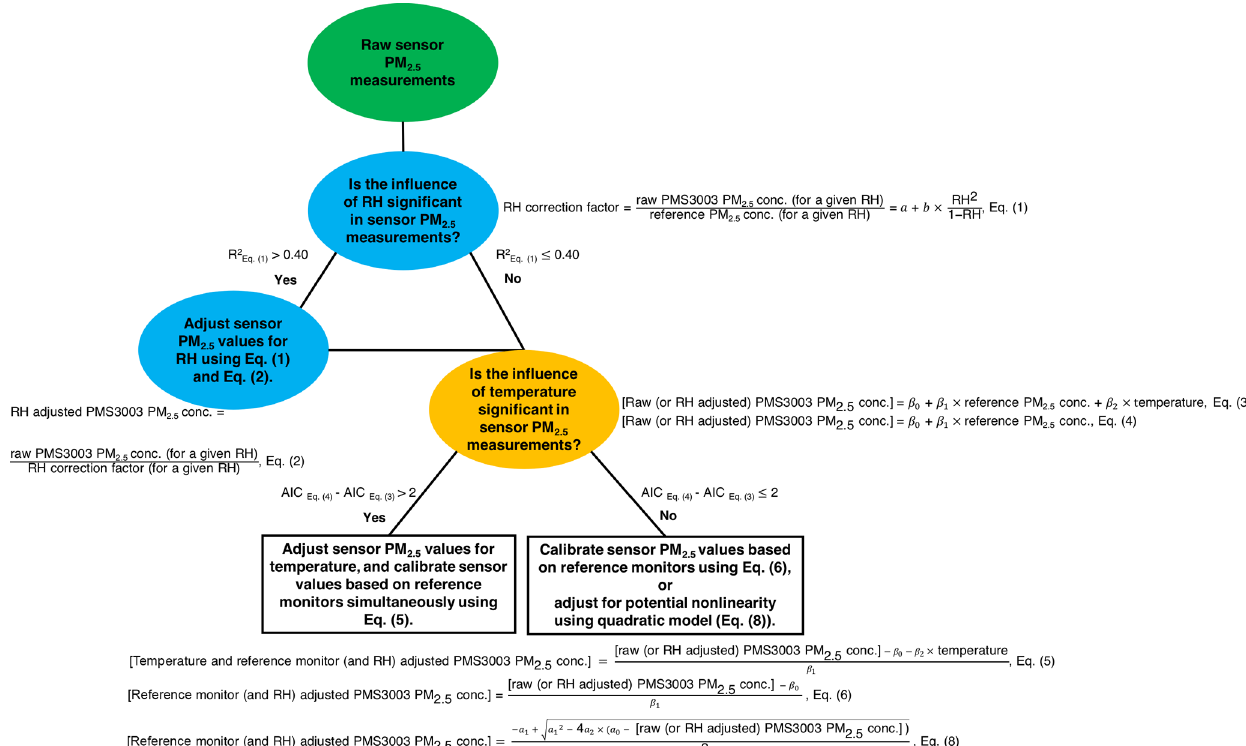
Figure 2. Flow path for sensor calibrations. Note raw sensor PM 2 . 5 measurements are uncalibrated sensor PM 2 . 5 measurements.